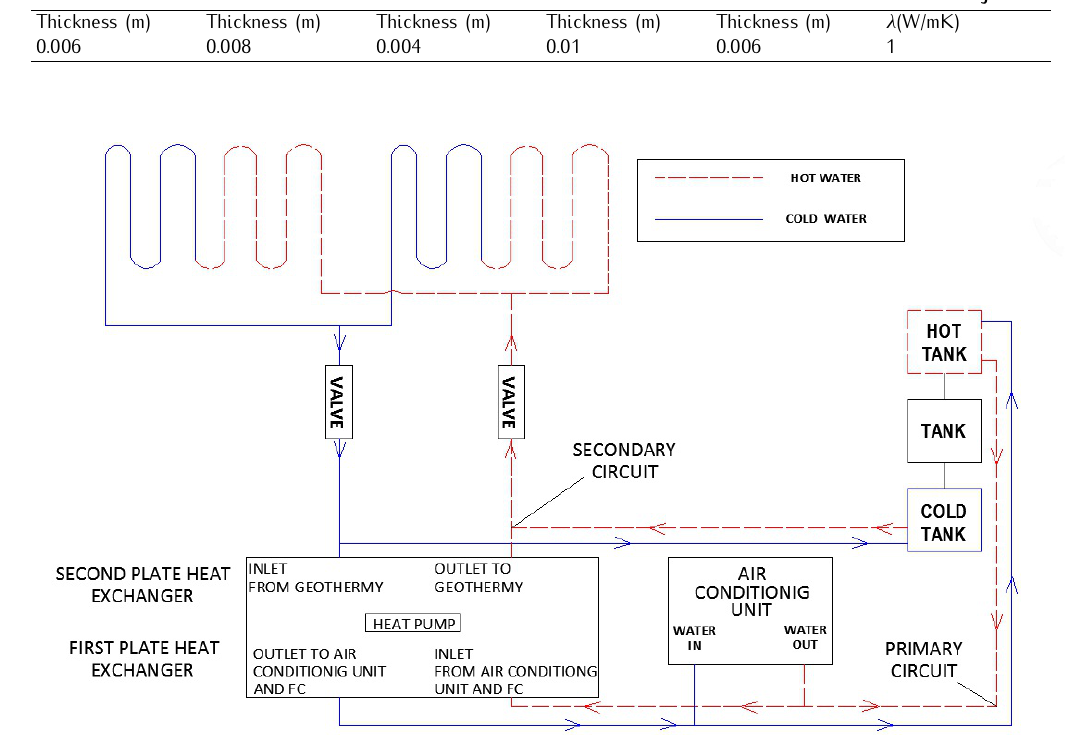
Figure 3. Heat pump